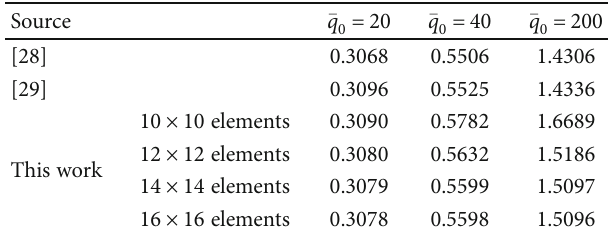
h of an isotropic c /